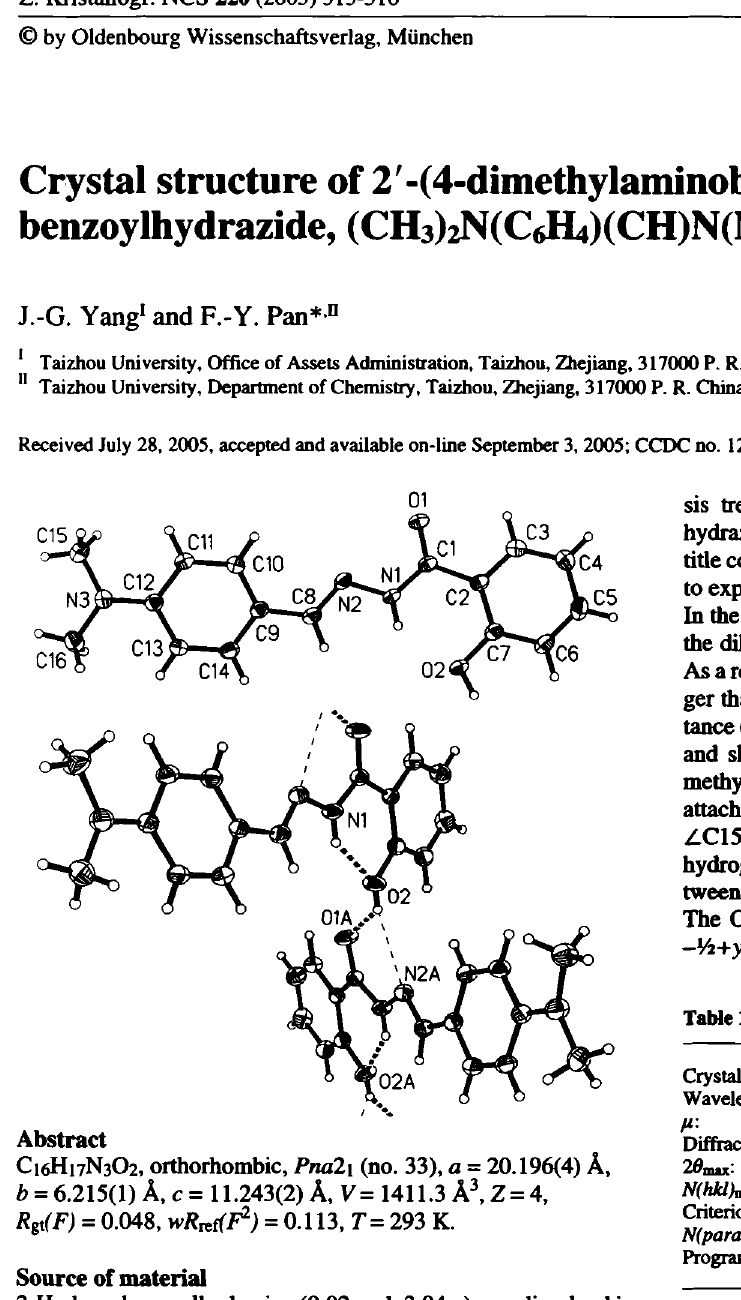
Table 1. Data collection and handling.